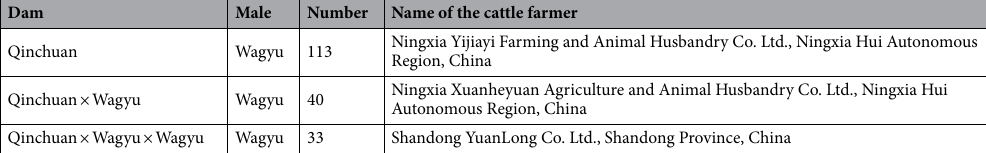
Table 1. The background information of samples.